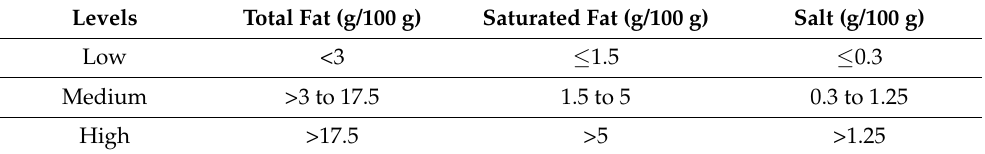
The sum of saturated and trans-fatty acids < 1.5 g/100 g (solids) and <0.75 g/100 mL (liquids), and in any case Low saturated fat content the sum of saturated fatty acids and trans-fatty acids should not provide more than 10% of the energy value. Low sugar content <5 g/100 g (solids) or 2.5 g/100 mL (liquids). <0.12 g of sodium, or the equivalent value of salt, per Low sodium/salt content 100 g or per 100 mL.